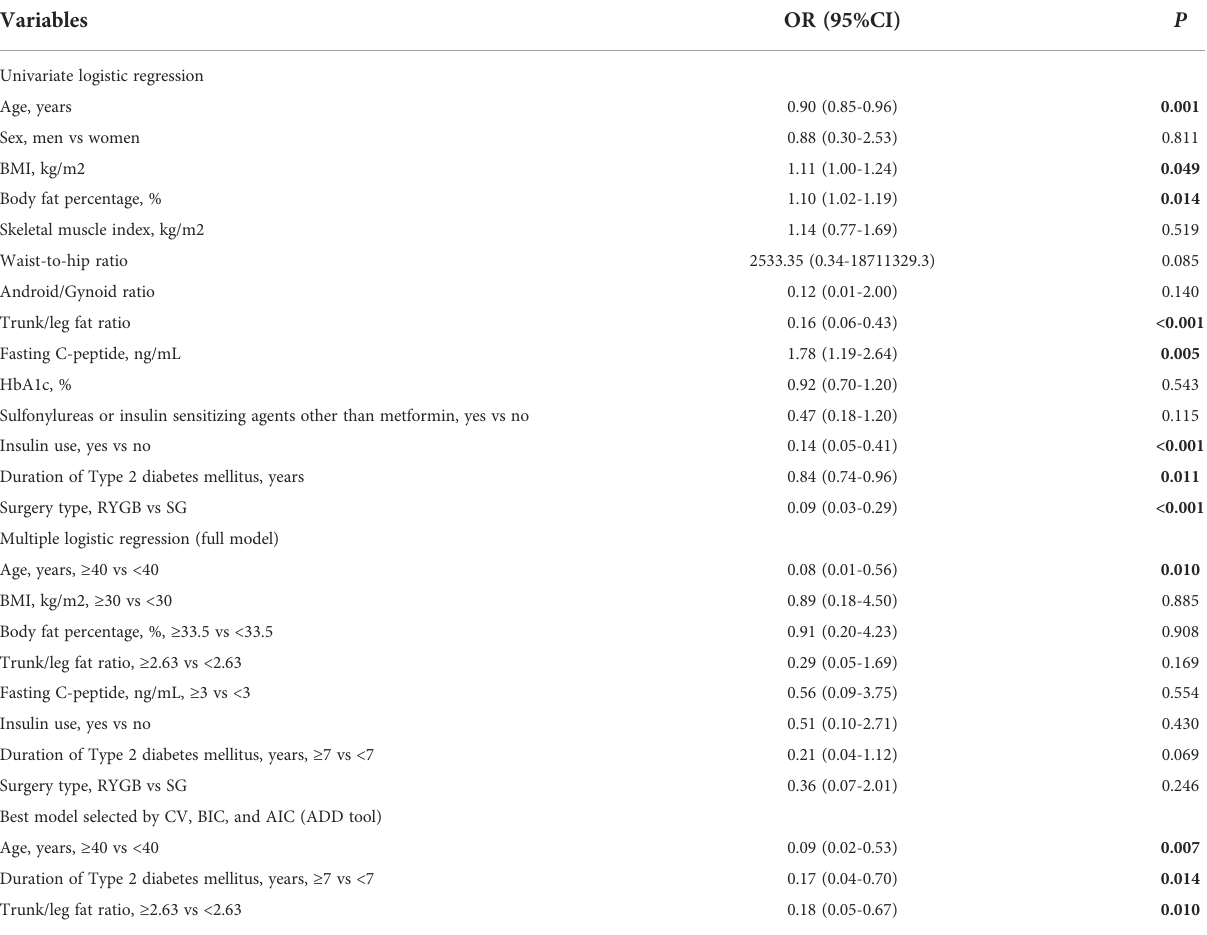
TABLE 3 Logistic regression analyses for predictor screening and model